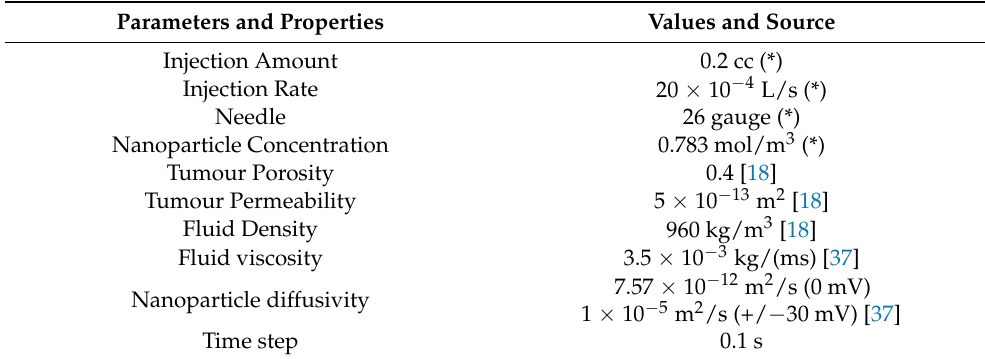
Table 1. Properties and parameters for the nanofluid convection and nanoparticle transport models. (* experimental data).